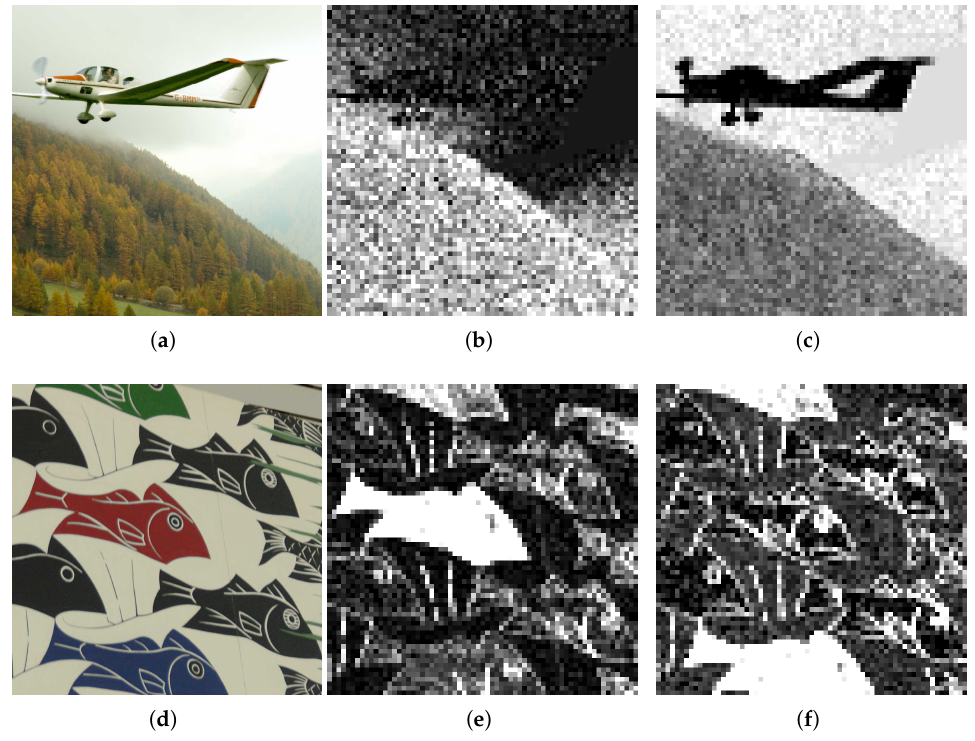
Figure 11. Alternative image estimations. Image ( a ) is tampered by adding a new element. DCT coefficients are not useful to discover the tampered region correctly when estimating every pixel ( b ). However, if acquired pixels remain unchanged, the tampered area is perfectly visible ( c ). Image ( d ) shows a colorization tampering. Detection is achieved by estimating with constant-hue demosaicing and applying the test on the red and blue channels. Results are shown in ( e , f ) respectively. Brighter zones show modified objects. This modification is not disclosed with green channel